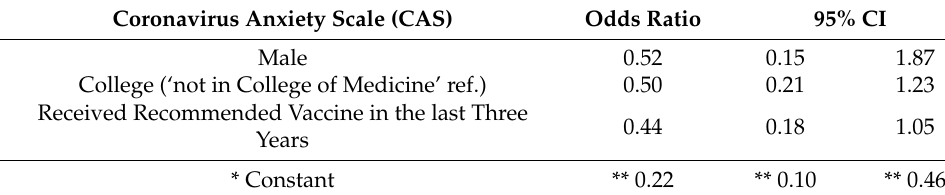
Table 8. Logistic Regression Model of the Coronavirus Anxiety Scale (CAS). Coronavirus Anxiety Scale (CAS) Odds Ratio 95% CI